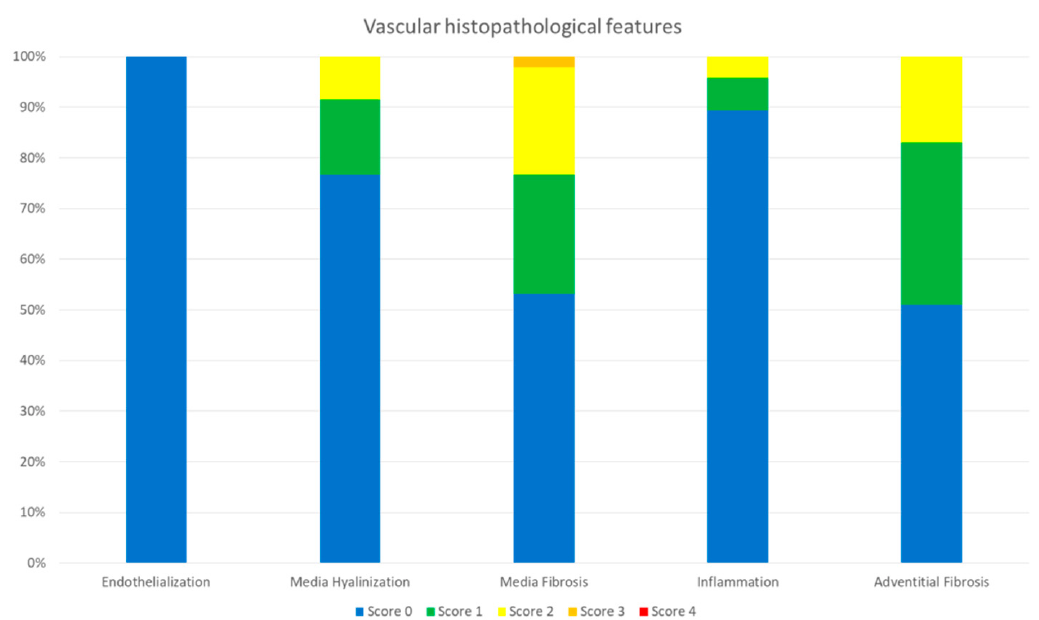
Figure 5. Vascular histopathological features in a DOCA minipig model after radiofrequency catheter-based renal denervation.